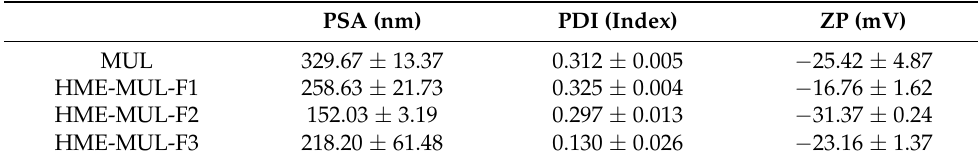
Table 4. Particle size (nm), PDI, and Zeta potential (mV) of prepared MUL and